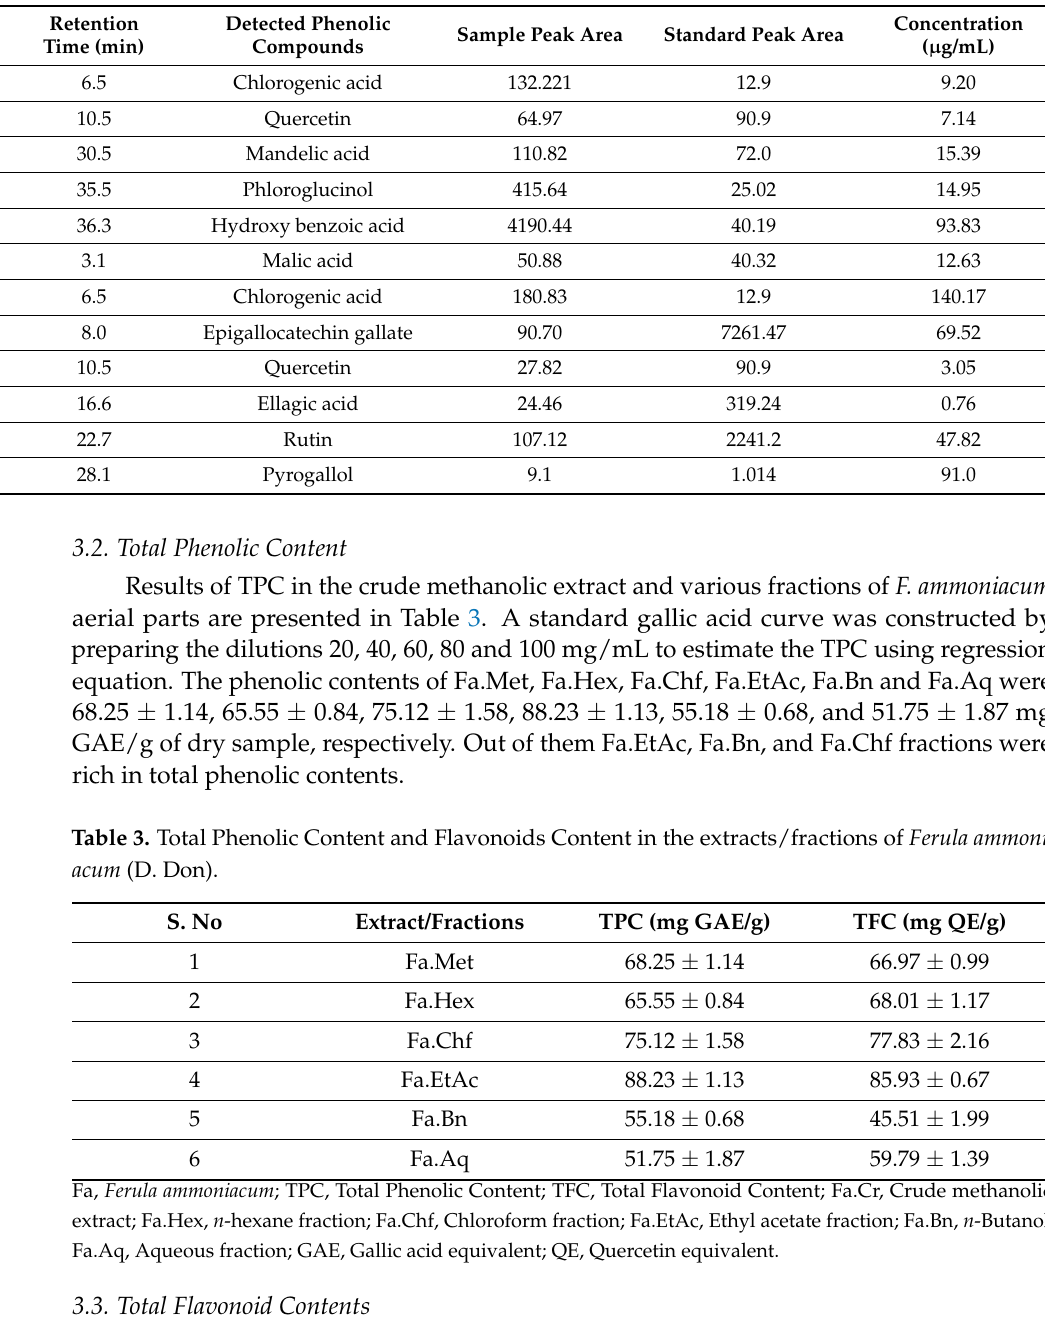
Concentration ( µ g/mL)